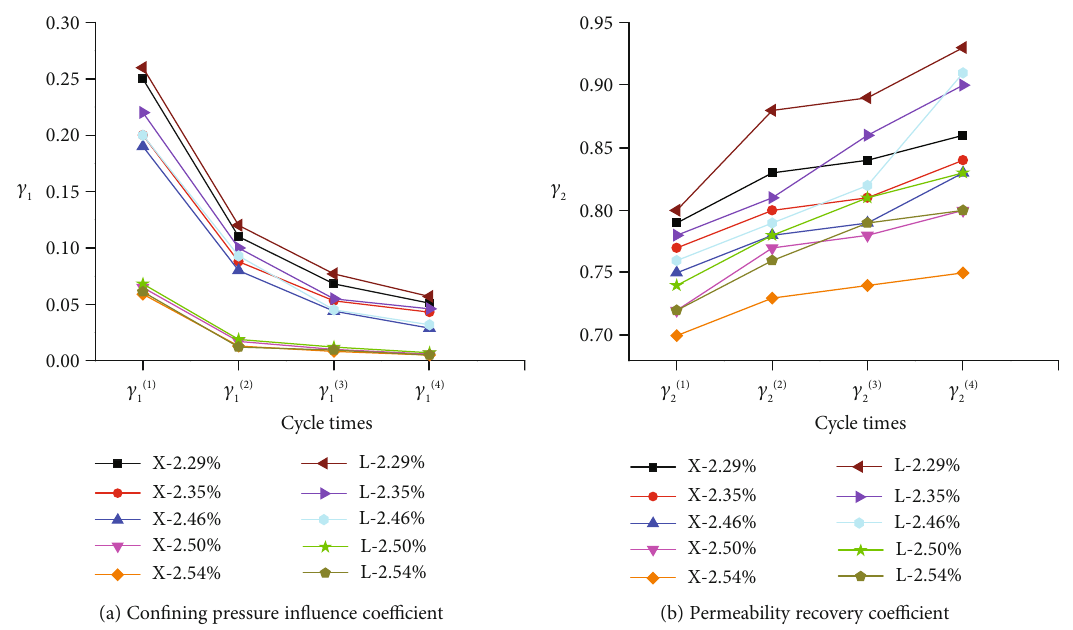
Figure 20: The comparison of the con fi ning pressure in fl uence coe ffi cient and permeability recovery coe ffi cient between two kinds of